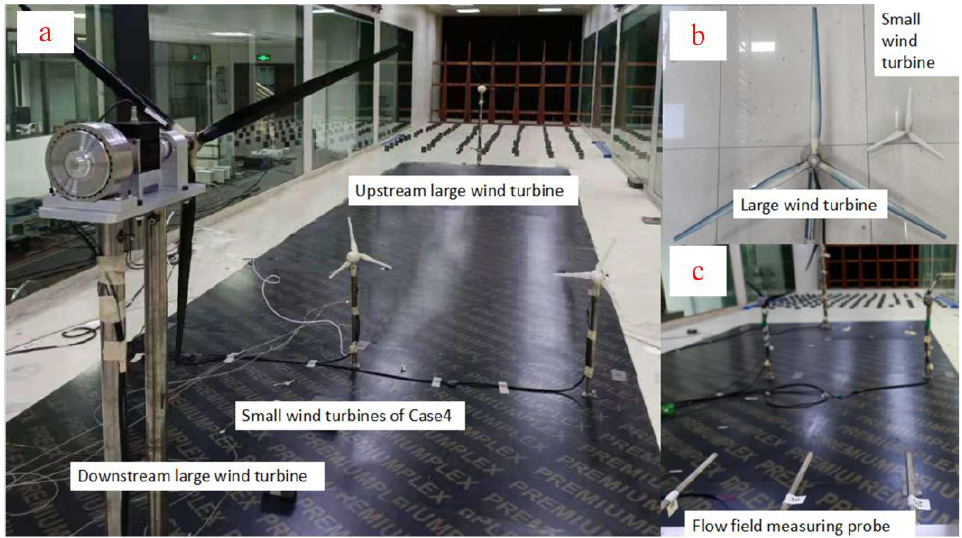
Figure 3. The layout of large and small wind turbines in the experiment, size of wind turbine and measurement equipment.